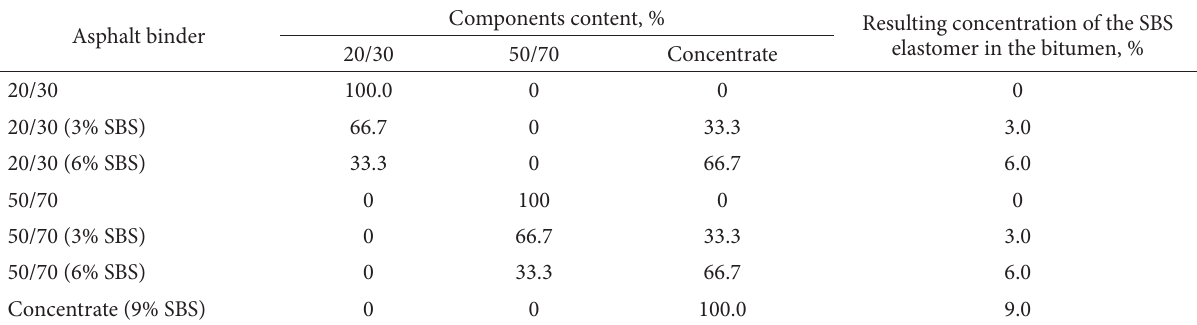
Components content,